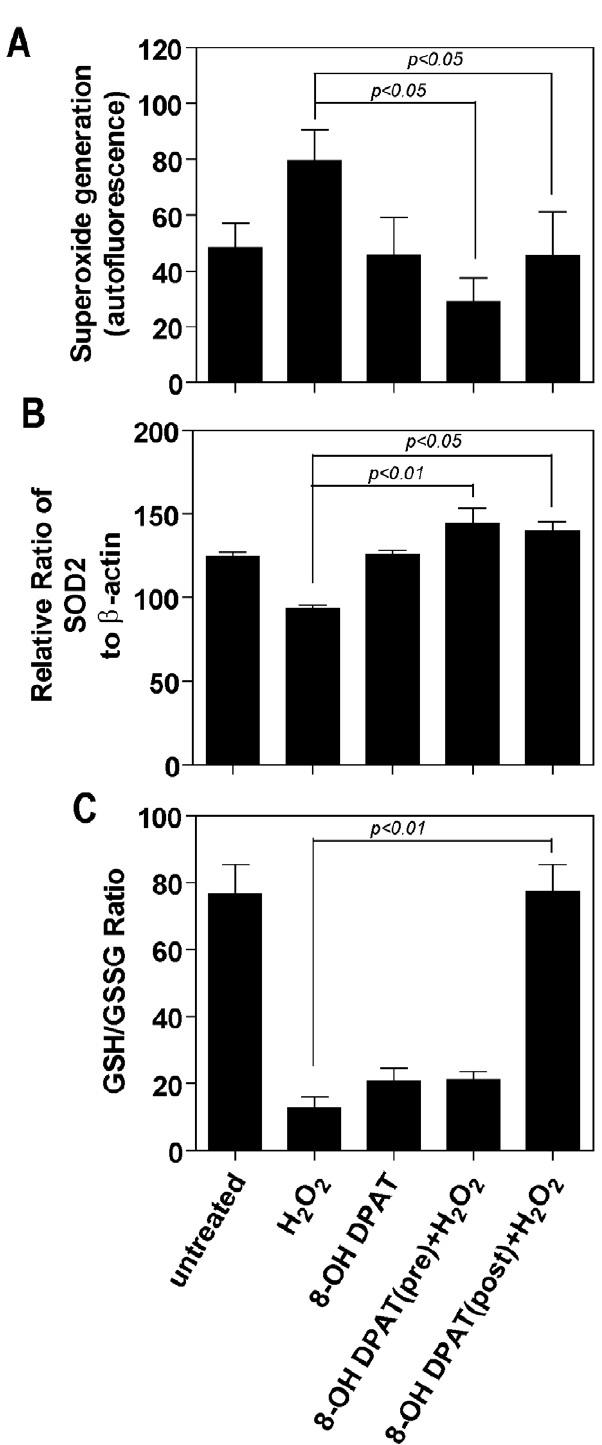
Figure 4. 8-OH DPAT reduces superoxide anion generation and increases antioxidant capacity in cultured RPE cells. Cells were exposed to H 2 O 2 (200 m M) for 1 hour and either pre-or post treated with 8-OH DPAT (10 m M) for 24 hours. In the case of pretreatment all measurements were made 24 hr after H 2 O 2 and for post treatment 8- OH DPAT was added immediately following H 2 O 2 exposure. A - Superoxide generation was measured using FACS analysis following staining with MitoSOX and results are expressed as the mean fluorescence intensity. B - SOD2 levels were determined by Western blot analysis. C - The ratio of reduced glutathione (GSH) to the